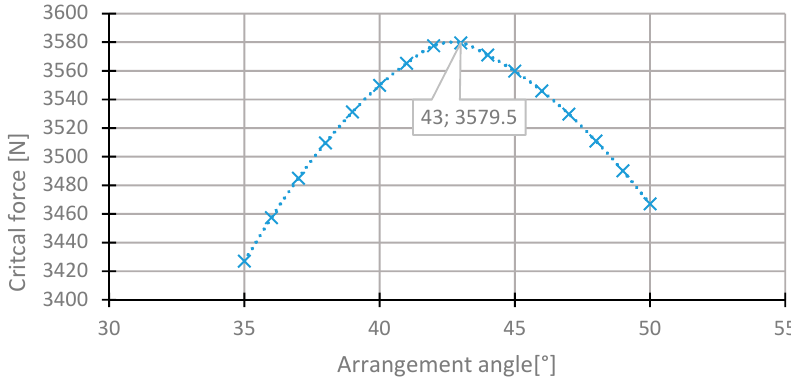
Figure 8. The critical force depending on the angle in the first layer of the laminate [45/ − 45/ − 45/45] for the change of the arrangement in the range 35°–50°.